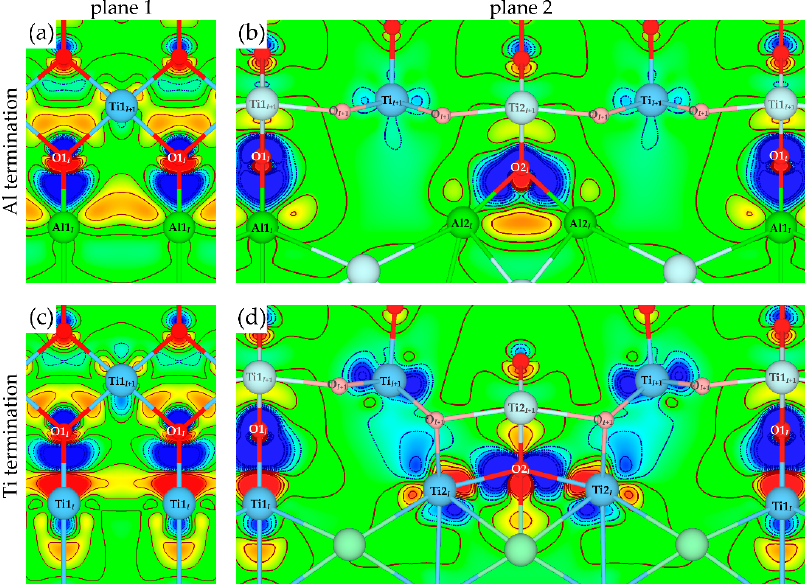
Figure 7. Distribution of the charge density difference ( Δ ρ ) at the TiAl/TiO 2 interface in the case of the top configuration in planes shown in Figure 3d: ( a , b ) Al termination; ( c , d ) Ti termination. The regions of electron accumulation ( ∆ ρ < 0) and depletion ( ∆ ρ > 0) are given in blue and red, respectively. Contours go –0.1 to 0.1 el. / Å 3 with an isoline spacing of 0.02 el. / Å 3 . Atoms being out of the figure plane are shown in lighter